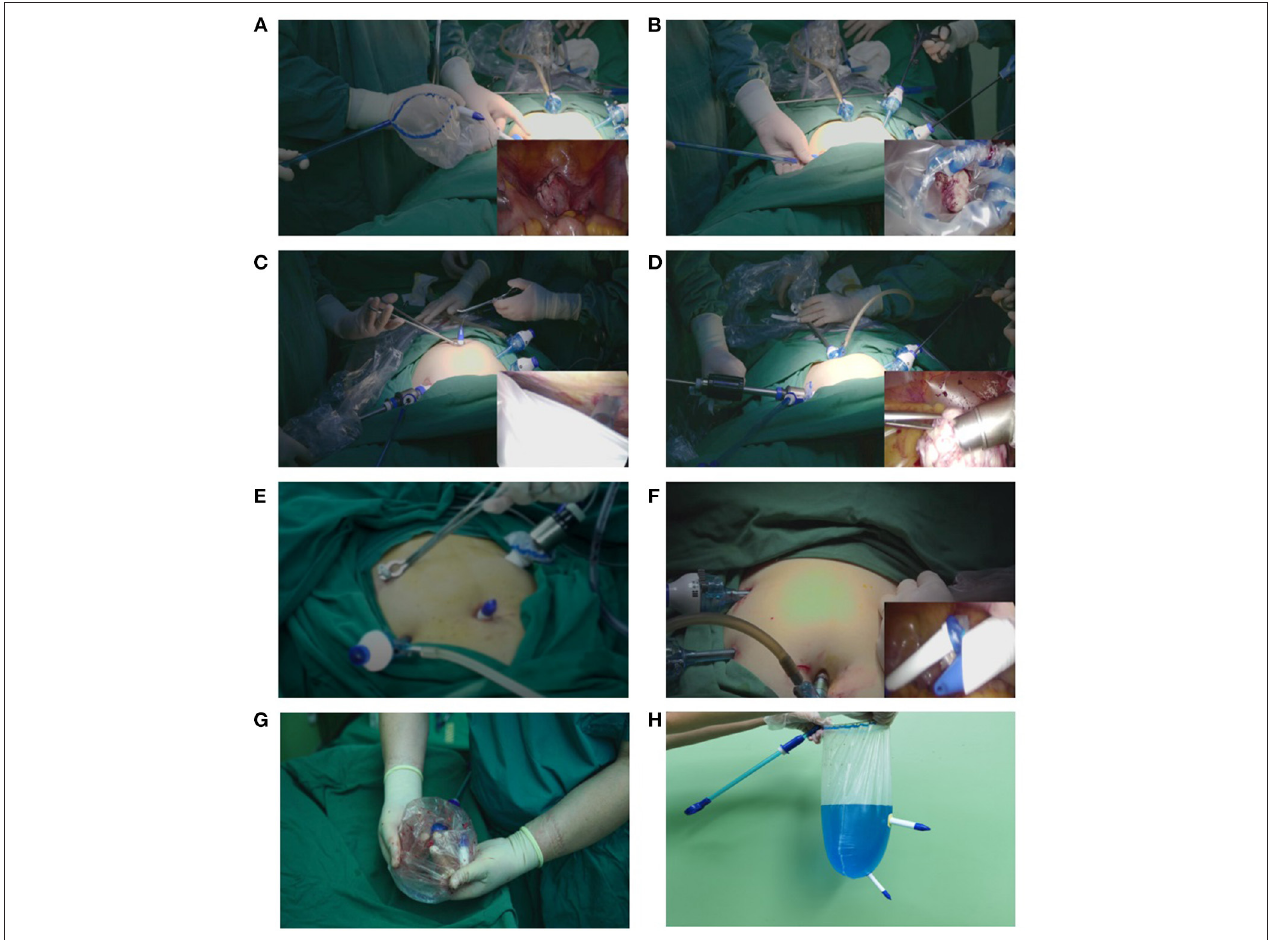
FIGURE 3 | Placement and extraction of the novel multi-port containment (NMC) system. (A) The bag is placed into the abdominal cavity through the right lower 20-mm introduction sheath. (B) The myoma is resected into the bag via its large opening. (C) The sealing caps on the hard sheaths are unscrewed and replaced with trocar bases. (D) The abdominal cavity is de-sufflated, and simultaneously, a pseudo-pneumoperitoneum is established by inflating the bag via the umbilical trocar. Thereafter, power morcellation is performed. (E) After morcellation, the trocar bases are unscrewed and replaced with the corresponding sealing caps. (F) The bag is removed through the introduction sheath. (G) Tissue and fluid remnants after morcellation in the NMC system. (H) 1,000-mL methylene blue solution is used to identify eventual system integrity.